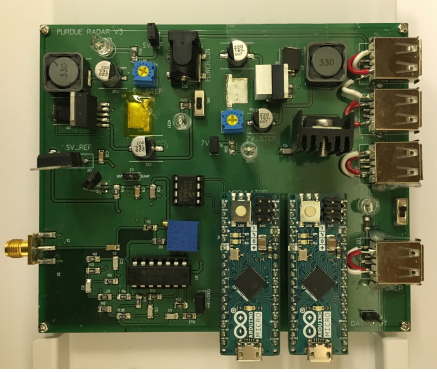
Figure 5. The second version of printed circuit board (PCB) for electronic parts.